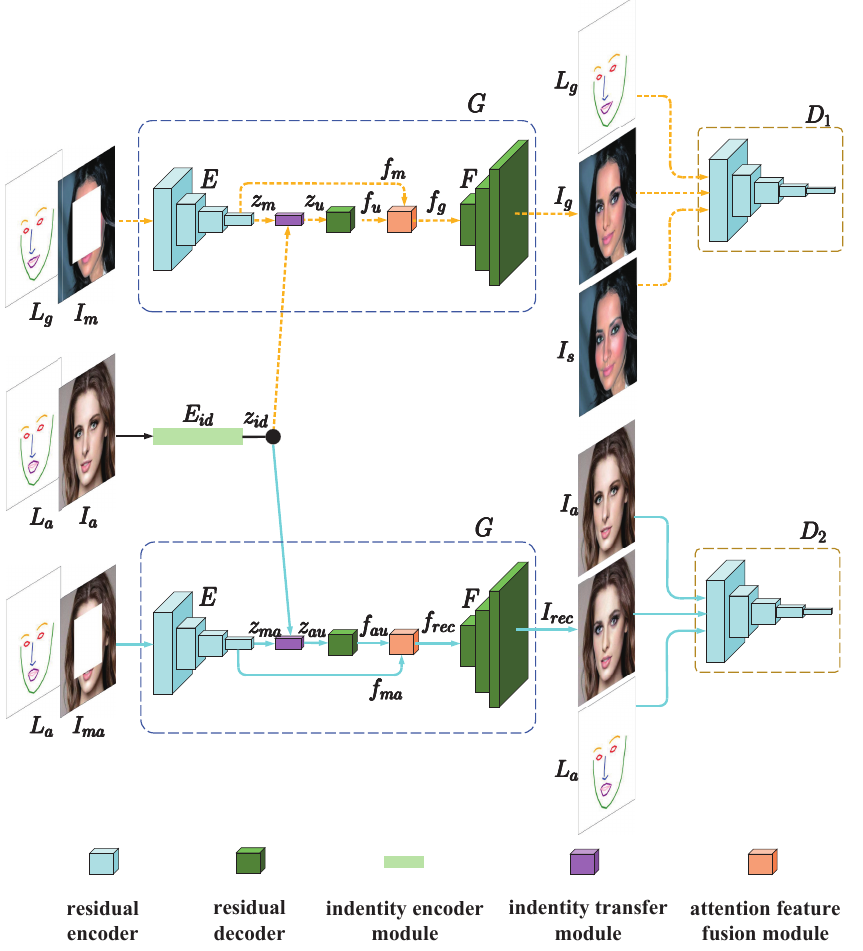
Figure 1. Overview of RG-DP-FICN with two parallel pipelines. The reconstruction pipeline ( blue line ) consisting of generator G and discriminator D 2 possesses all the information on reference images from I a I a I a , which is used only for training. The completion pipeline ( yellow line ) consisting of generator G and discriminator D 1 is used for training and testing. Two piplines share identical generator G and identity encoder E id , the generator consists of encoder E and discriminator F . The structure of the residual encoder and residual decoder is the same as [15]; Identity encoder module and identity transfer module is further described in Section 2.3; attention feature fusion module is further described in Section